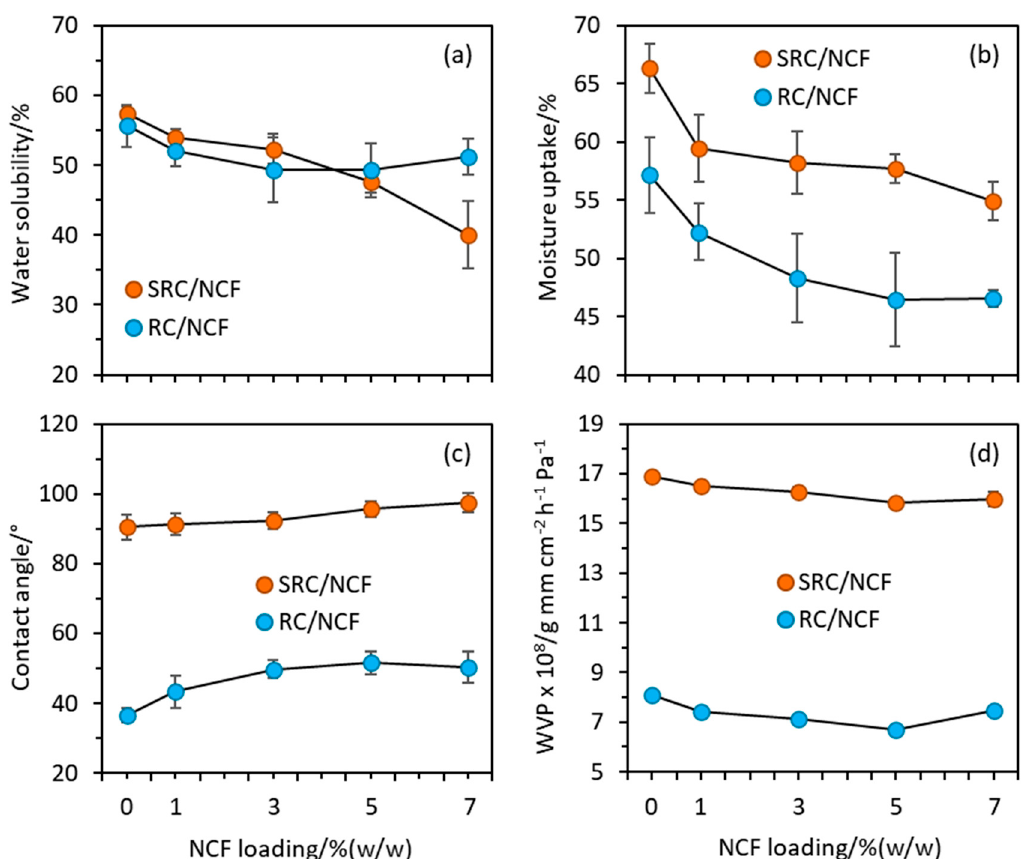
Figure 3. Plots of ( a ) water solubility, ( b ) moisture uptake, ( c ) contact angle, and ( d ) water vapor permeability (WVP) against NCF loading for the SRC/NCF and RC/NCF film